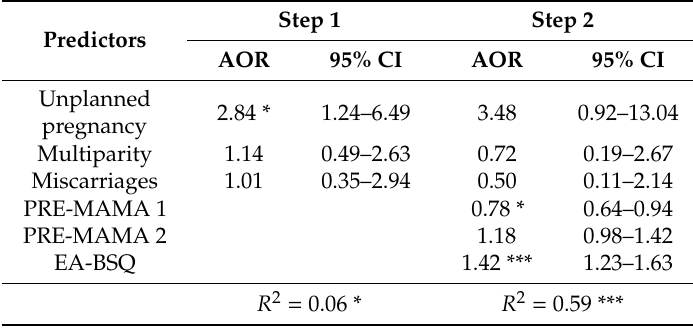
Table 4. Hierarchical binary logistic regression predicting depression ( N =